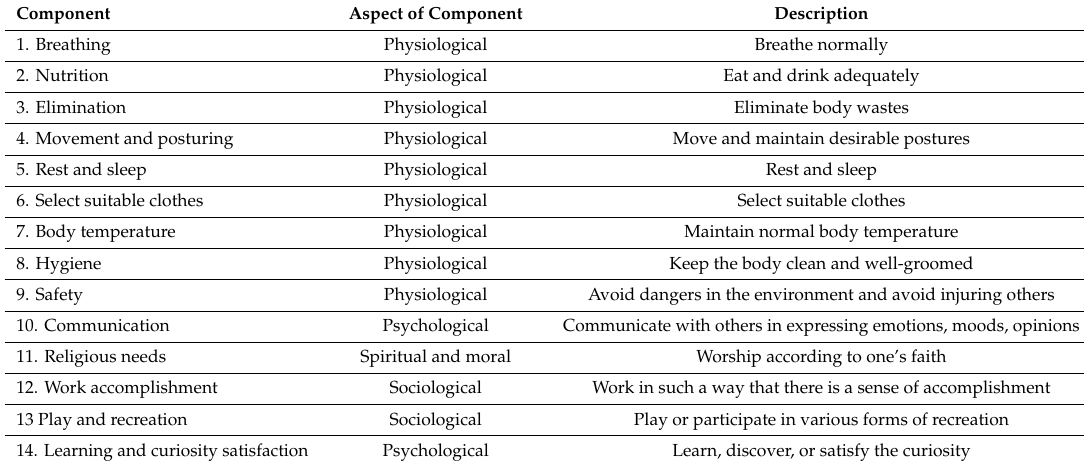
Table 1. Description of the components according to Henderson’s